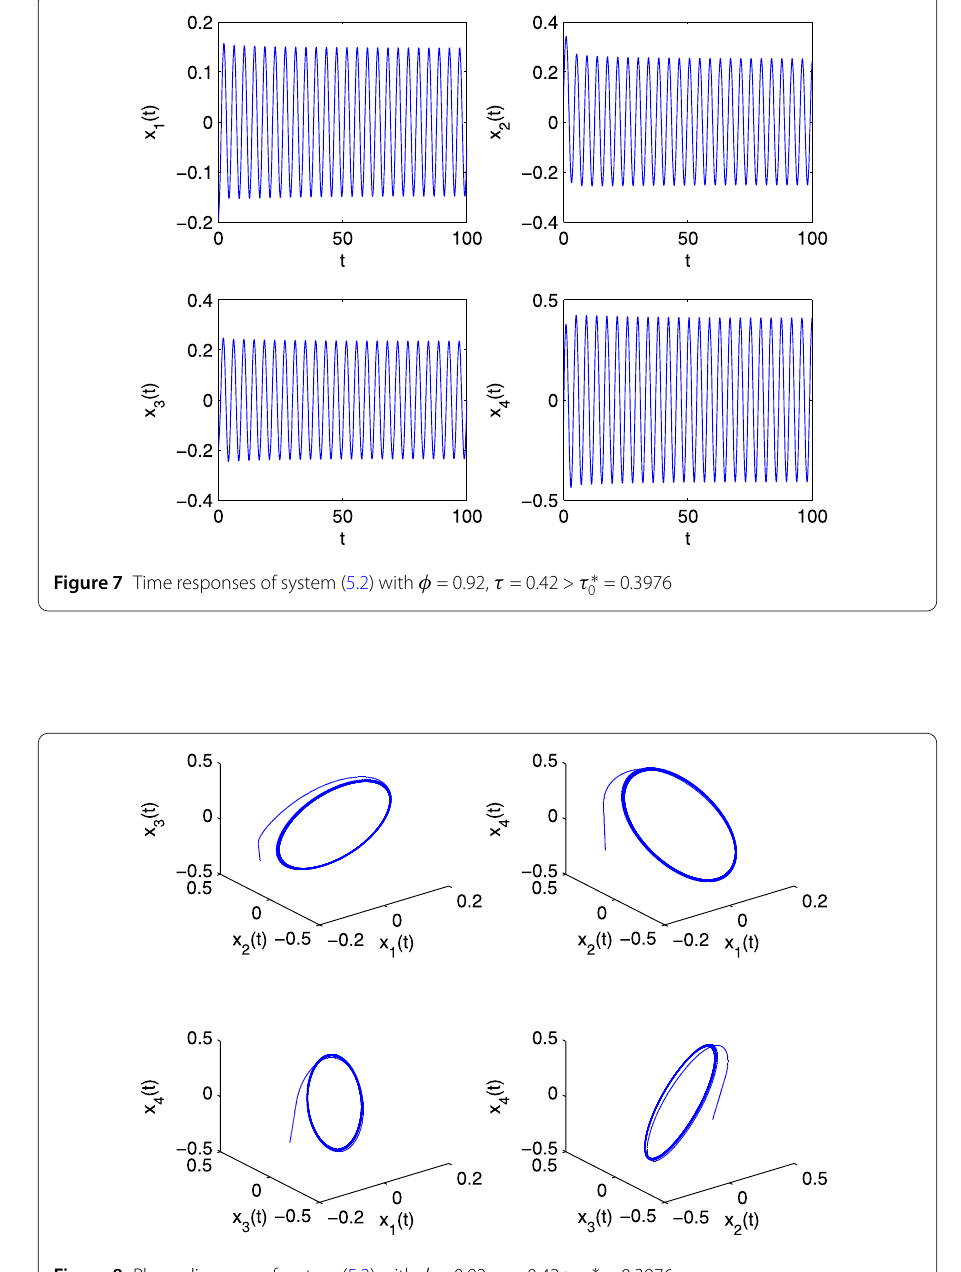
Figure 8 Phase diagrams of system (5.2) with φ = 0.92, τ = 0.42 > τ ∗ 0 =